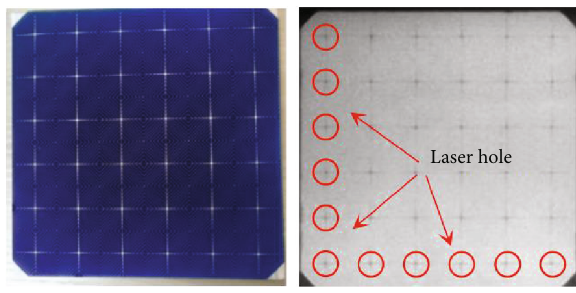
Figure 6: Front and PL image of single